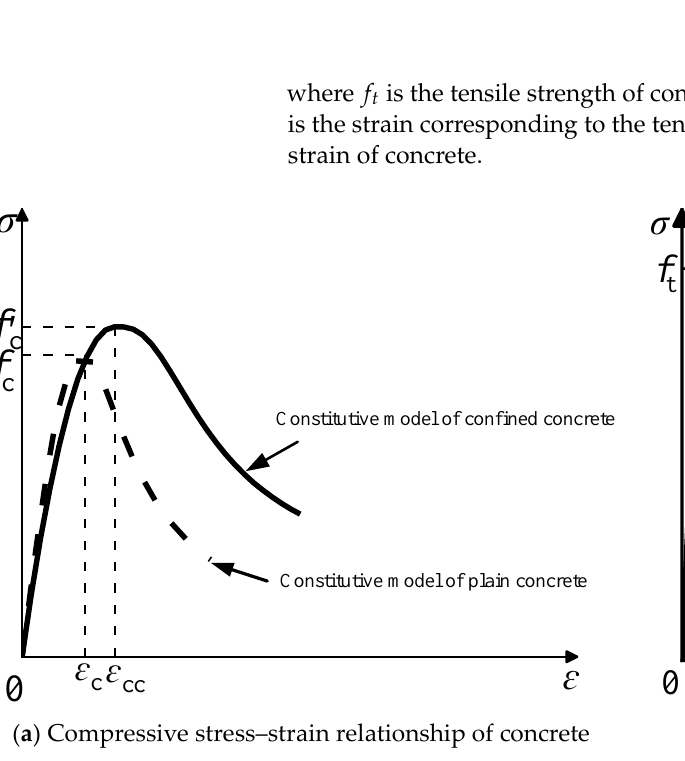
Figure 5. Stress – strain curves of concrete. Figure 5. Stress–strain curves of